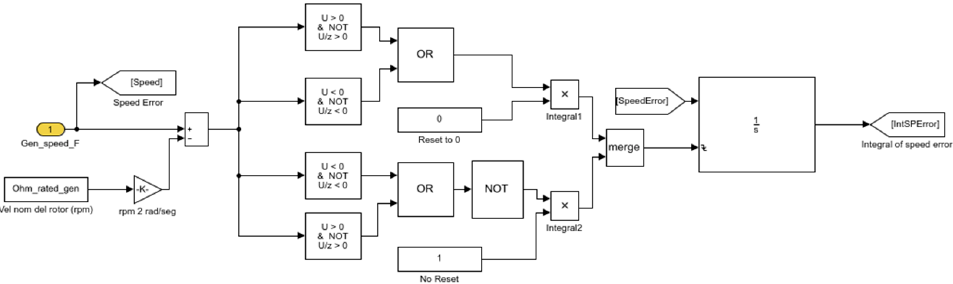
Figure 7. Implementation of the Anti-Wind-Up block in SIMULINK.